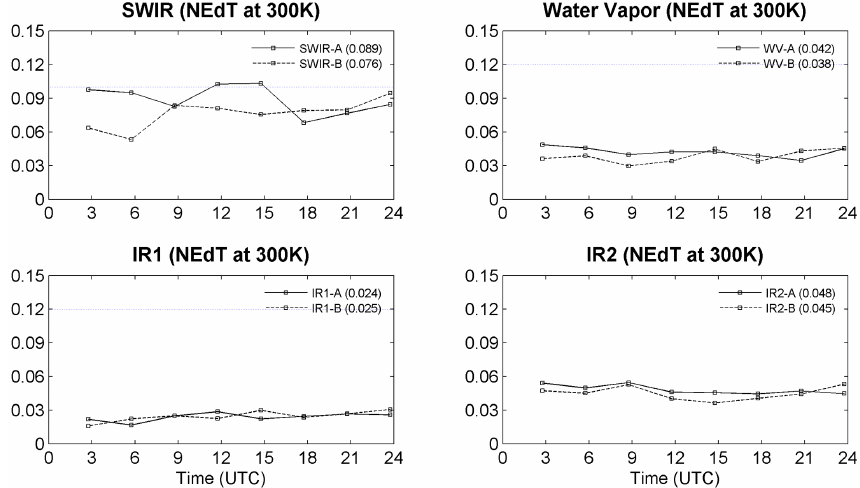
Figure 8. Diurnal variation of NEdT at 300K of four IR channels for each detector in the channel during the January 2011. Diurnal mean of NEdT for each detector is in parentheses. Dashed lines indicate the requirement at a given channel in Table 4. Note that the requirement of NEdT of IR2 is 0.2. Data of full-disk images are presented in 3h intervals. Table 5. Comparison of COMS/MI noise performance with the legacy instruments onboard previous weather satellites. The IR2 channel is not available after GOES 12, which has the new carbon dioxide channel instead of the IR2 channel. The performance values of the legacy instrument are from Hillger and Schmit (2011). In the case of COMS/MI, the performance values are for detector number 1 and number 2. Band COMS G-15 G-14 G-13 G-12 G-11 G-10 G09 G-08 SWIR 0.070 0.063 0.053 0.051 0.13 0.14 0.17 0.08 0.16 0.070 WV 0.080 0.170 0.18 0.14 0.15 0.22 0.09 0.15 0.27 0.060 IR1 0.060 0.059 0.06 0.053 0.11 0.08 0.20 0.07 0.12 0.040 IR2 0.110 0.20 0.24 0.14 0.120